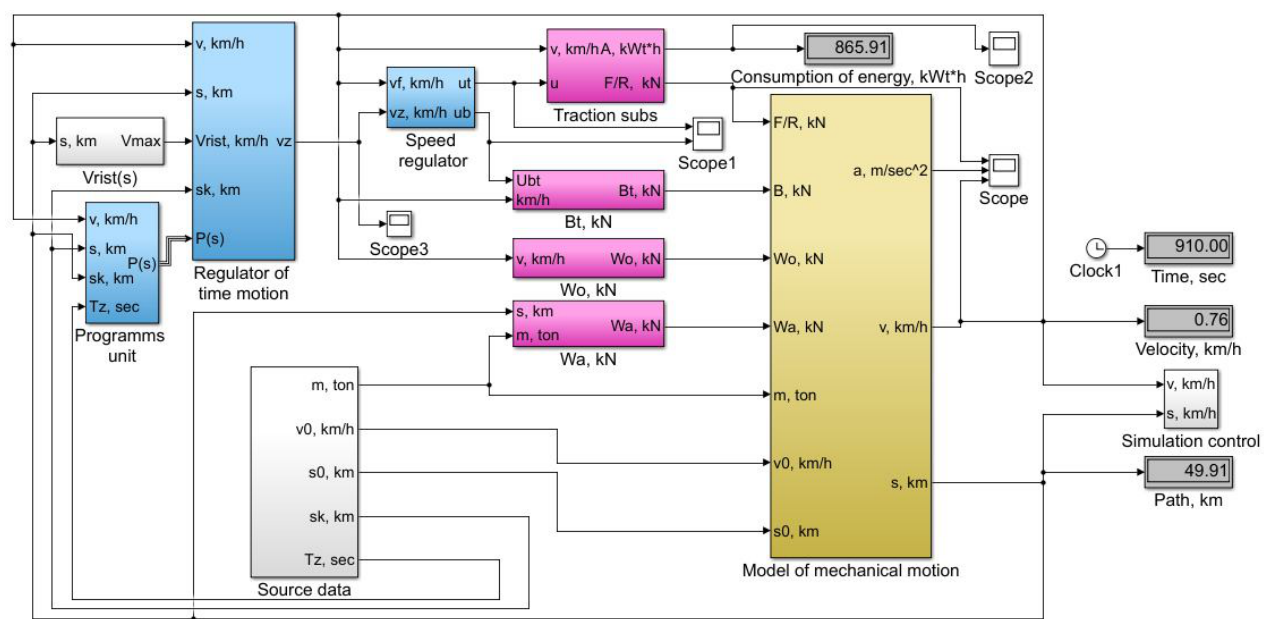
Figure 2. The block-scheme of simulation model of train movement in